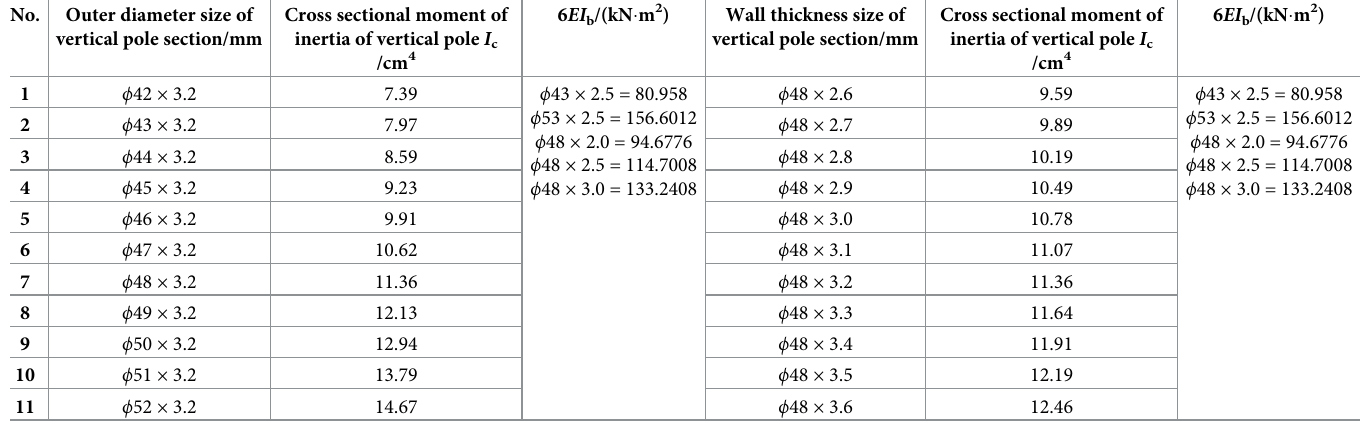
Table 9. Parameters related to section size of vertical pole and the effective length correction